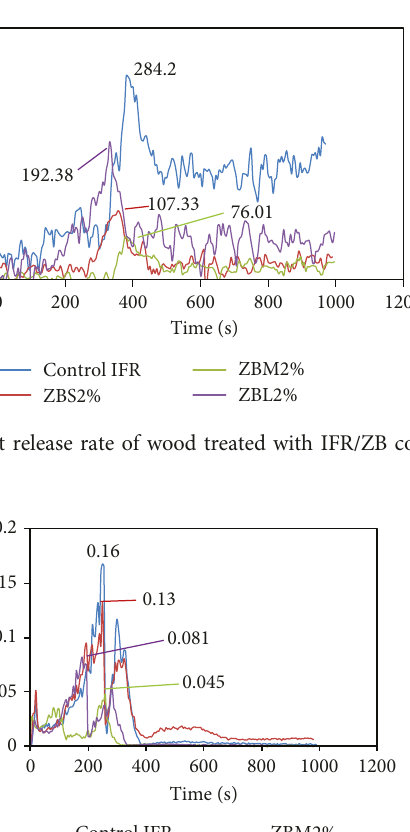
Figure 8: Total heat release of wood treated with IFR/ZB coatings (50 kw · m -2 ).